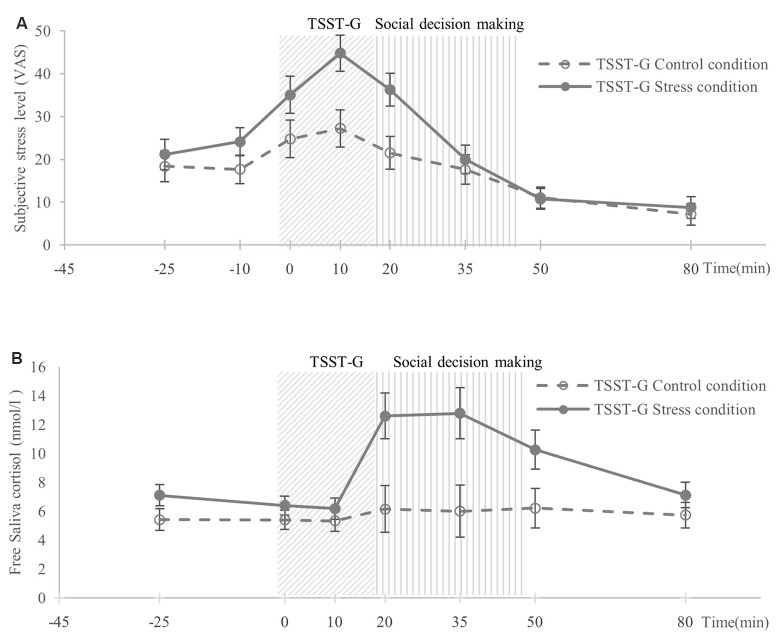
Participants’ (A) mean level of subjective stress, (B) mean level of salivary cortisol. Time 0 was the start of the Trier Social Stress Test for Groups (TSST-G; von Dawans et al., 2011). Error bars indicate standard errors of the mean.